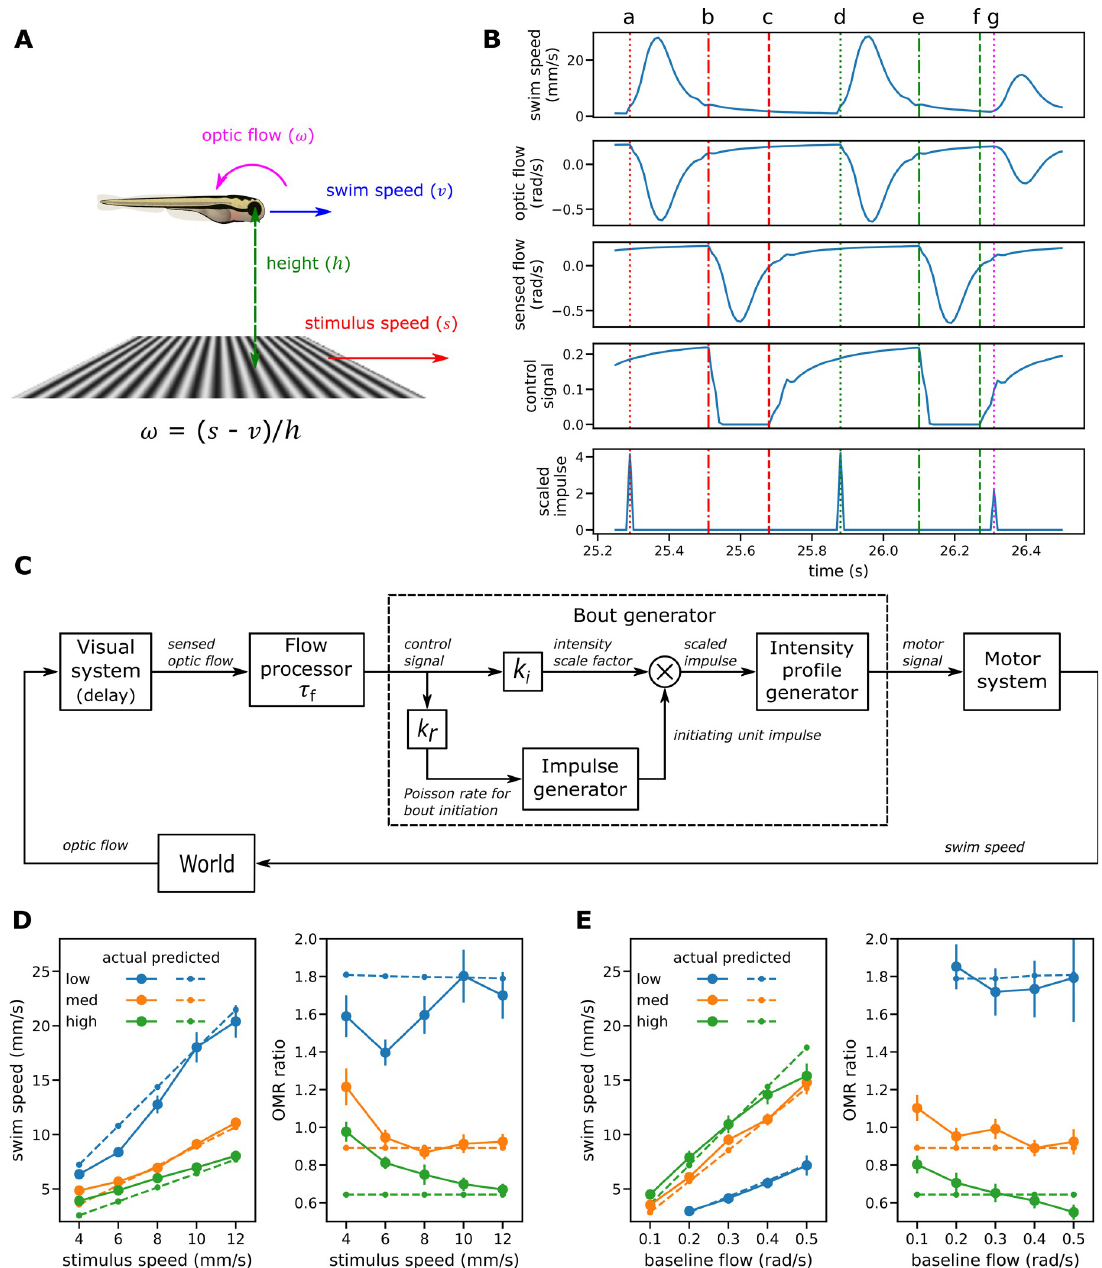
Fig 4. Modeling I: Single process model. Operation of the single process model. For further details see main text and the more formal model description section of the Methods. (A) Fish swimming in the same direction as a moving grid below. The resulting translational optic flow, expressed as an angular velocity, is the ratio of the difference between grid speed and swim speed and the height of the fish above the grid, as explained in Fig 1B. (B) Sample traces generated by the single factor model. The top two traces show the observable variables swim speed and optic flow; the bottom traces show three key model variables. The vertical lines show events occurring during the first bout (red, a-c), second bout (green, d-f) and third bout (magenta, g). (C) Block diagram for the single factor model. The sensed flow is a delayed version of the actual optic flow. The flow processor smooths the sensed flow by applying leaky integration and rectifies it to produce the control signal input to the bout generator. Within the bout generator, the amplified control signal drives an impulse generator that implements a Poisson process for the event of bout initiation. The same control signal also modulates the amplitude of the initiating impulses from the impulse generator to produce scaled impulses input to the profile generator. The profile generator in turn generates a swim bout that starts when the scaled impulse is received and whose speed follows the fixed relative swim speed profile observed scaled up by the amplitude of the scaled impulse. The model has three parameters to fit to data: the time constant for leaky integration ( τ f ) and the gains applied to the control signal to determine the Poisson rate for bout initiation events ( k r ) and the